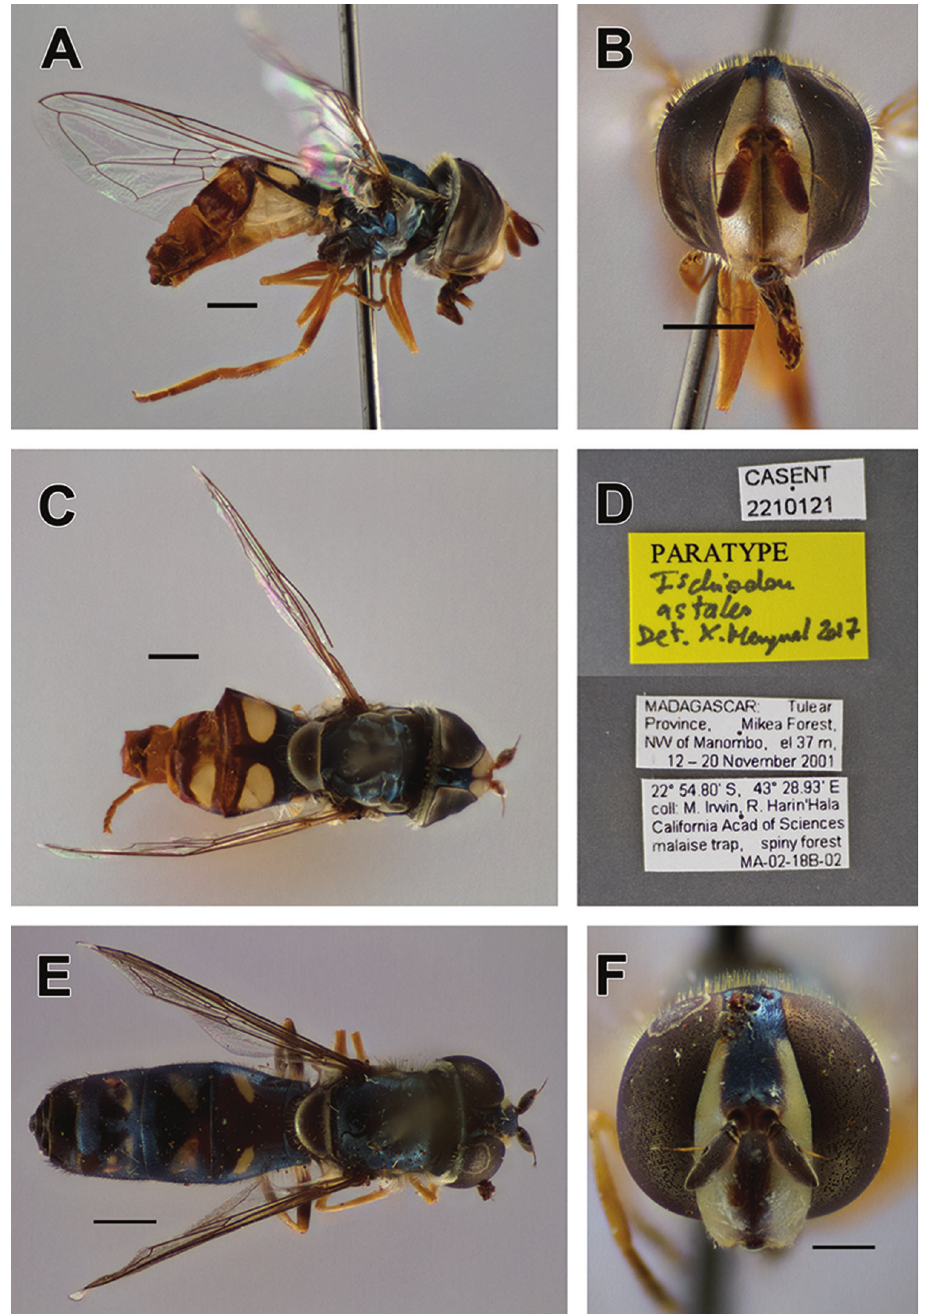
Figure 3. Ischiodon astales sp. n., female paratype CASENT 2210121: A Habitus, lateral view B Frontal view C Habitus, dorsal view D Labels. Ischiodon feae (Bezzi), female GJ.1985: E Habitus, dorsal view F Frontal view. Scale bars: 1 mm ( A – C , E ); 0.5 mm ( F